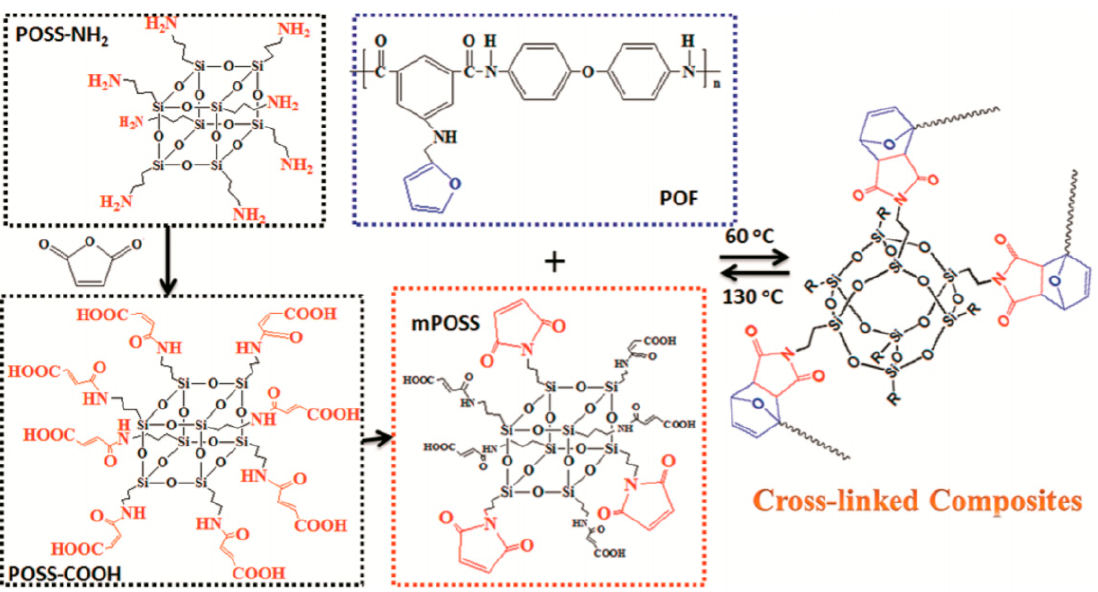
Figure 25. Synthetic route to obtain the cross-linked polyhedral oligomeric silsesquioxane (POSS) and thermal reversibility. Reproduced from [114]. Copyright 2016 American Chemical Society.